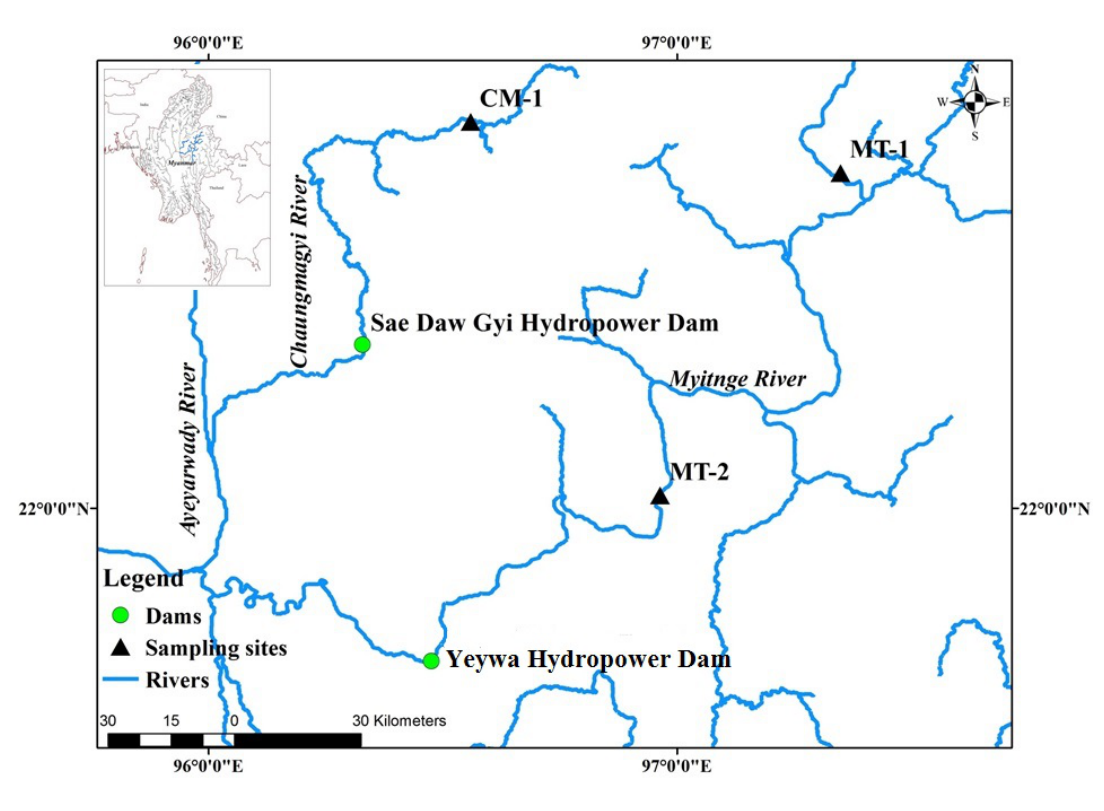
Figure 1. Locations of selected sampling sites on the Myitnge and Chaungmagyi Rivers in Myanmar. MT, Myitnge River; CM, Chaungmagyi